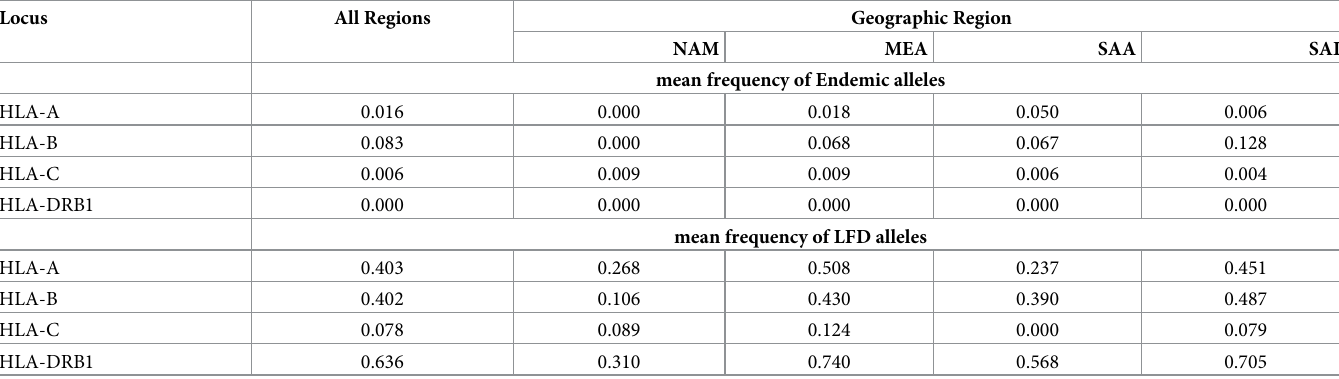
For each locus, the mean frequency for endemic and LFD alleles was computed over the set of populations in the geographic region. The first column refers to continental average.